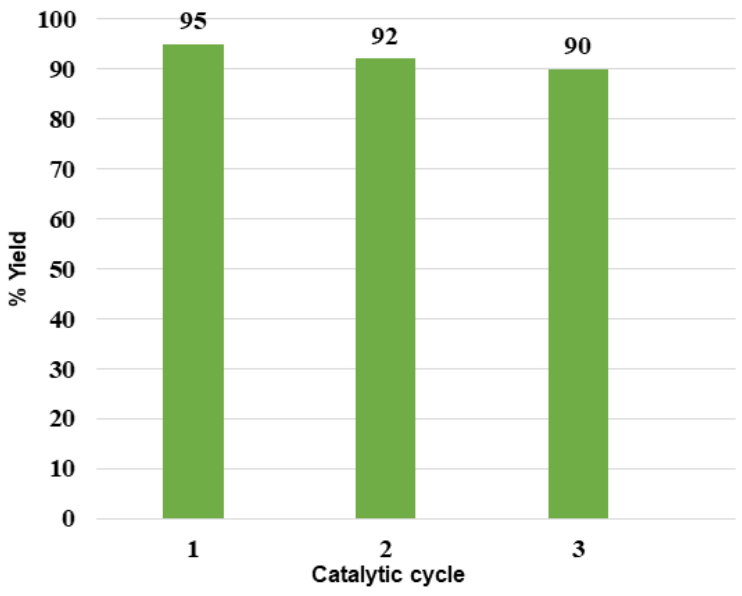
Figure 6. Recyclability details of catalyst 2 . Results of three cycles are shown. Table 5. Comparison of the results of the synthesis of 3,4-dihydro-5-ethoxycarbonyl-4-(4-phenyl-6- methylpyrimidine-2(1 H )-one using different